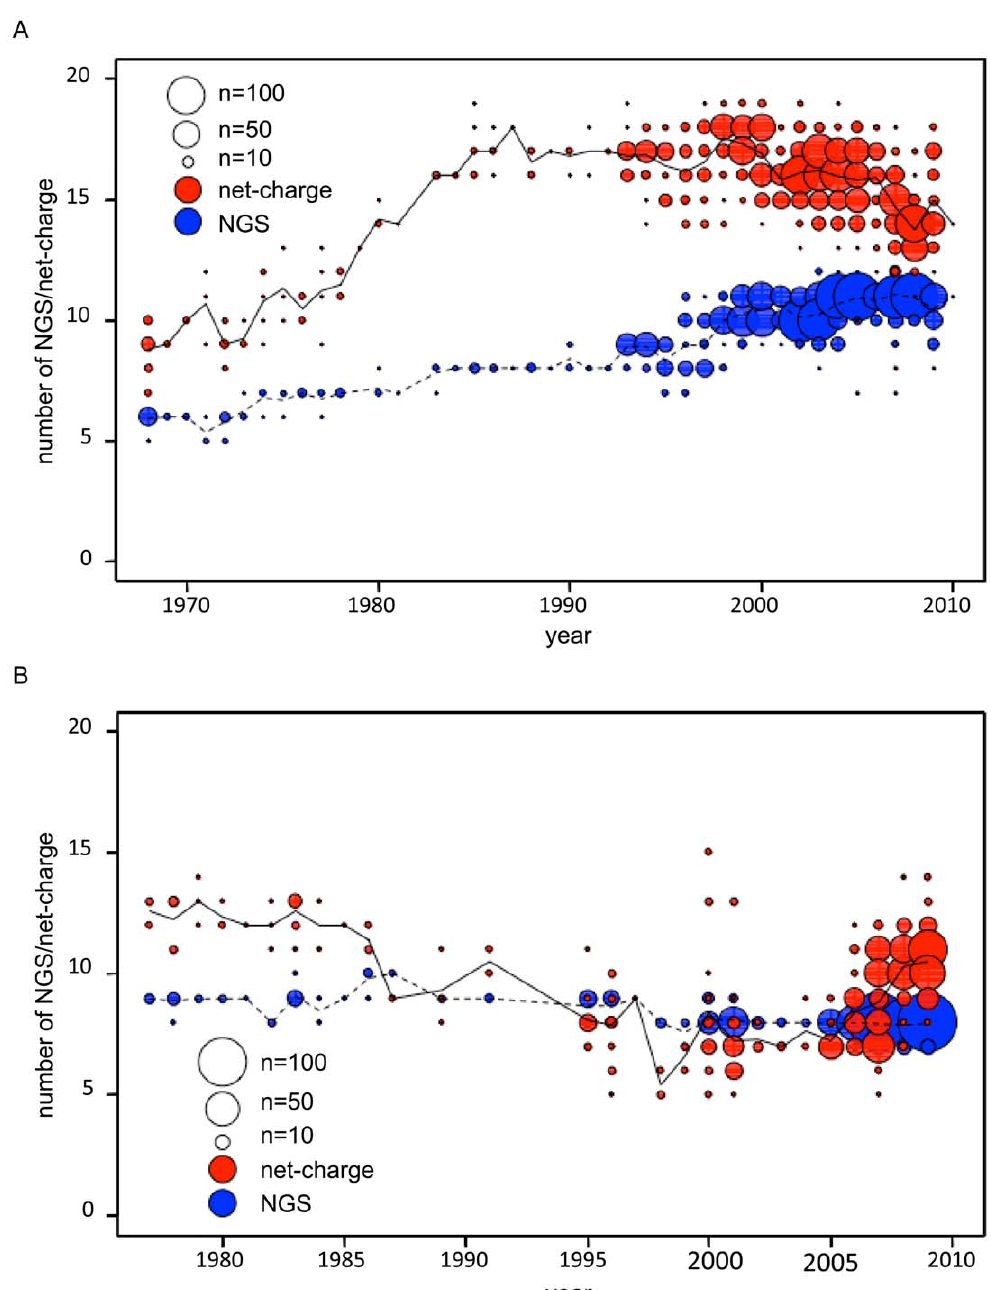
Figure 1. Temporal changes in the net-charge and the number of NGS in HA1. The net-charge (red circles) and the number of NGS (blue circles) in HA1 were plotted against the year of isolation for each strain of (A) A/H3N2 ( n =1,903) and (B) A/H1N1 ( n =723) viruses. The area of the circles is proportional to the frequencies of the strains, with the scales indicated at the corner. The solid and dashed lines represent the average values of the net-charge and the number of NGS in HA1 for the viruses isolated in each year, respectively.